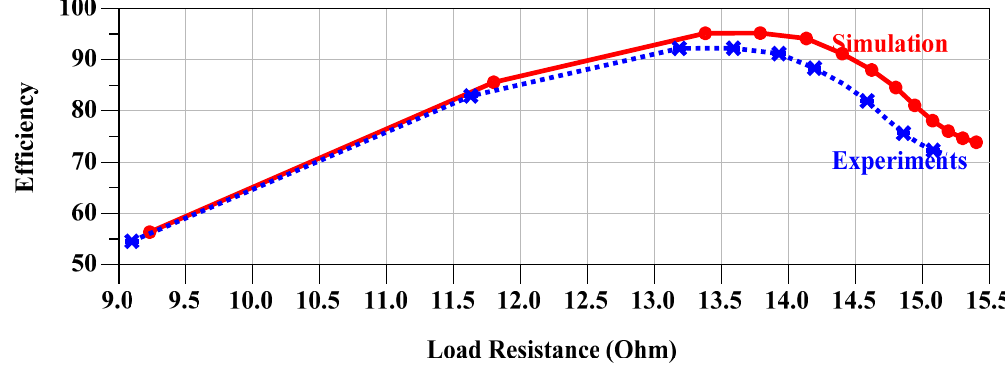
Figure 21. Comparison of simulated and experimental Efficiency.